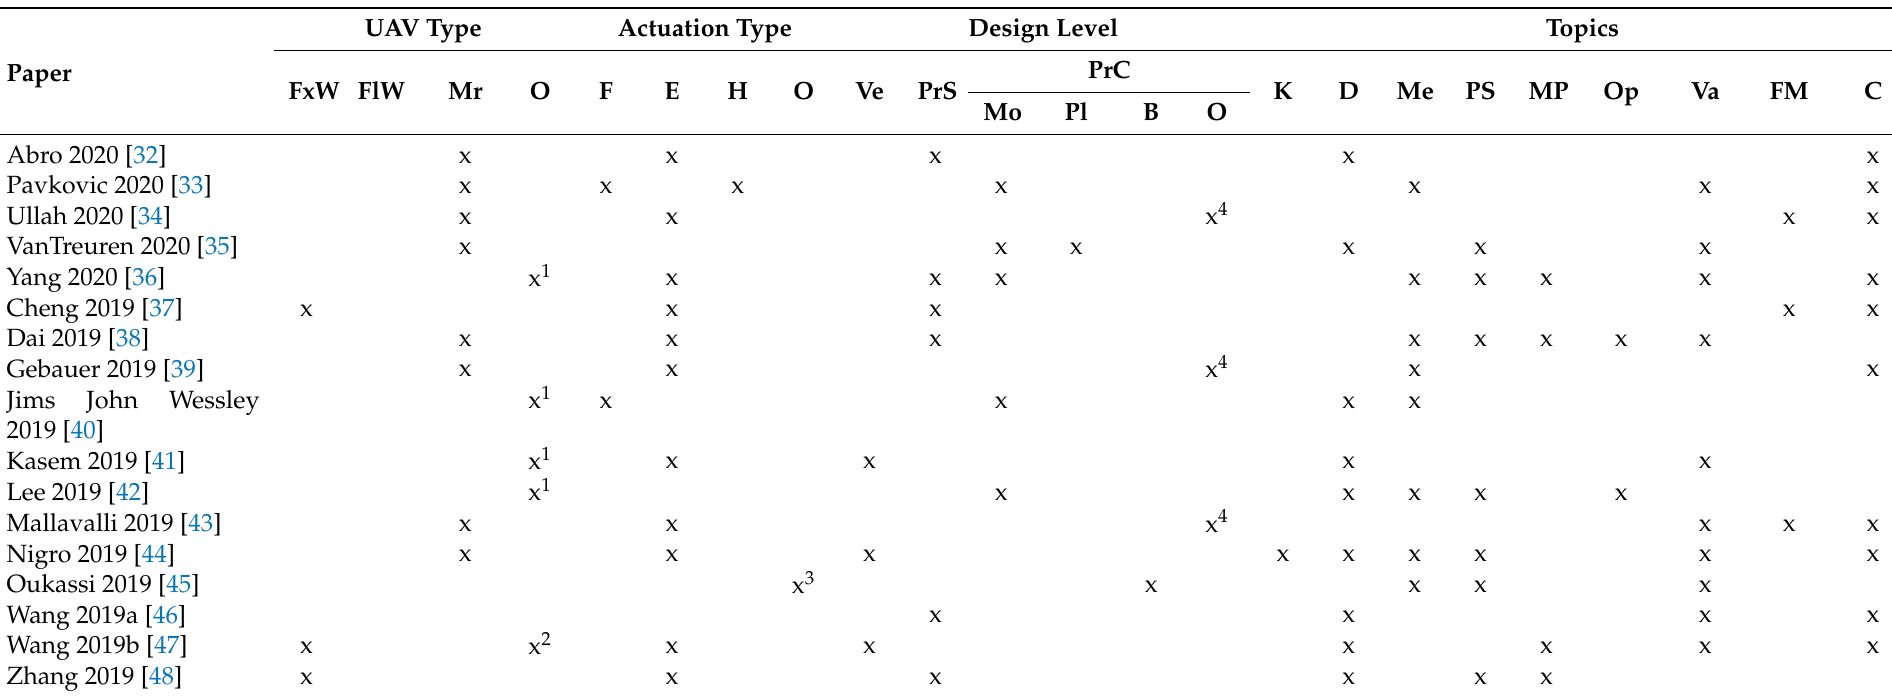
Table 5. Evaluation of the papers categorized in the controls, identification, modeling category from 2019, according to the taxonomy referring to the paper content.